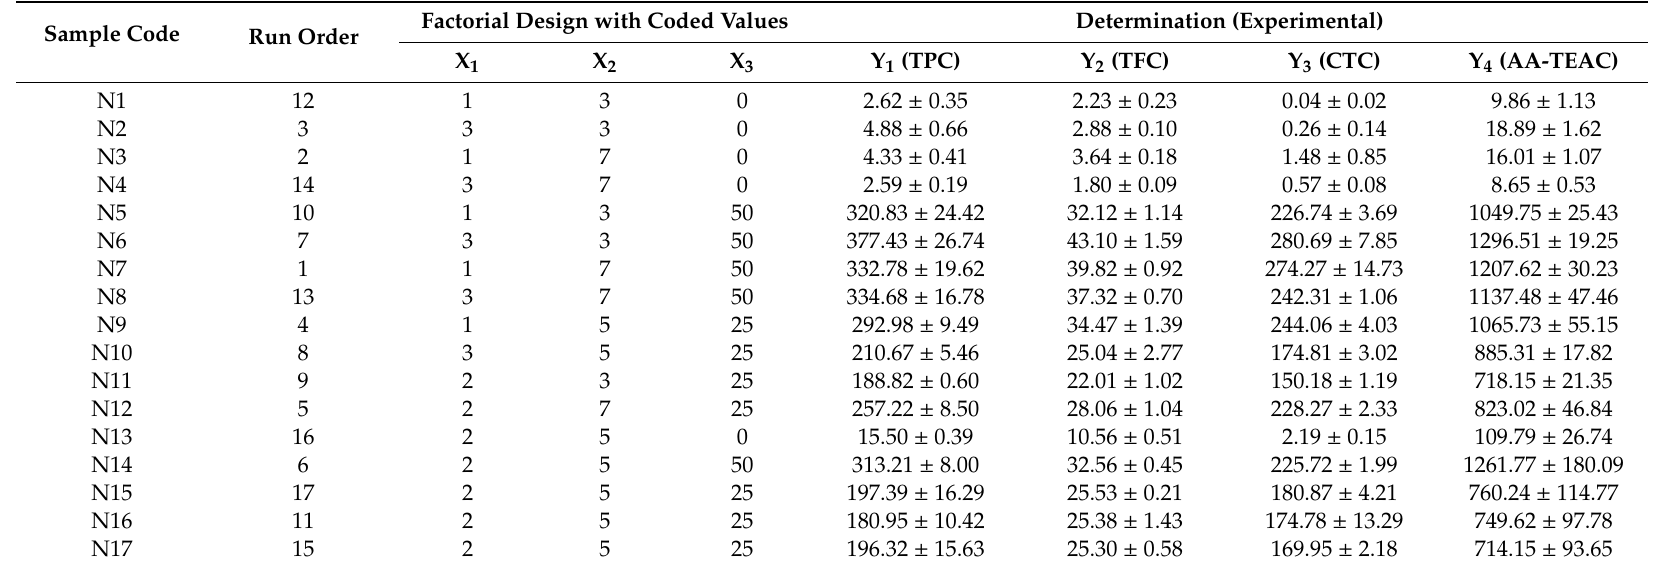
Table 3. Matrix of experimental design and results for total phenolic content, total flavonoid content, condensed tannin content, and antioxidant activity of hazelnut involucre extracts based on a factorial design during the screening step.